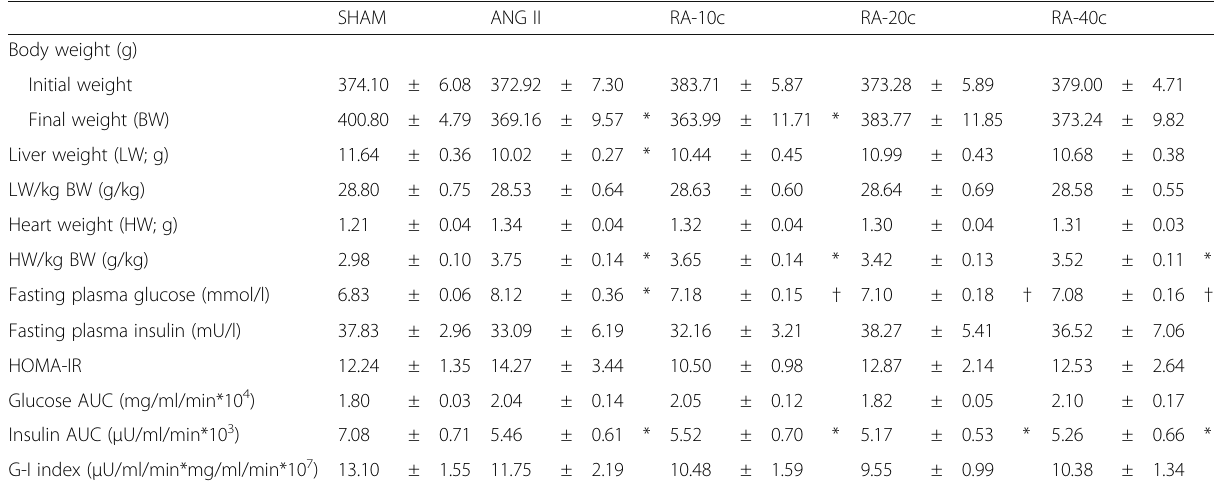
Table 2 Animal characteristics and glycemic control in SHAM and ANG II-treated rats and in ANG II-treated rats following chronic administration of RA at 10, 20, or 40 mg/kg SHAM